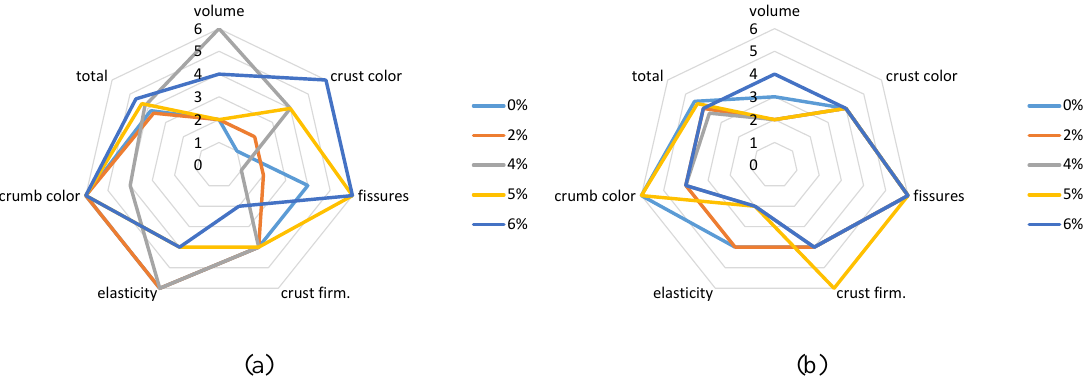
Figure 3. Sensory characteristics of bread samples made from white flour ( a ) and whole-wheat flour ( b ) after frozen storage for 111 and 110 days, respectively.